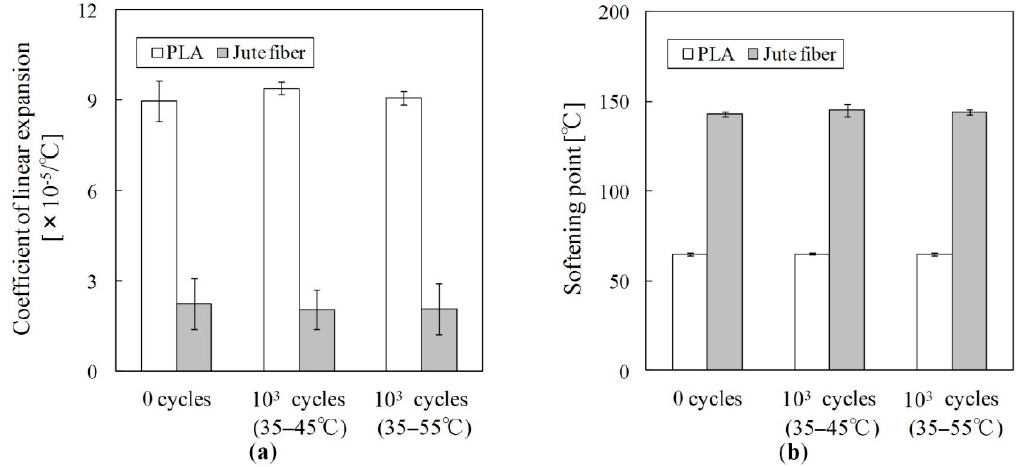
Figure 3. Thermal mechanical analyses of jute fiber and PLA after thermal cycling: ( a ) Coefficient of linear expansion; ( b ) Softening point.